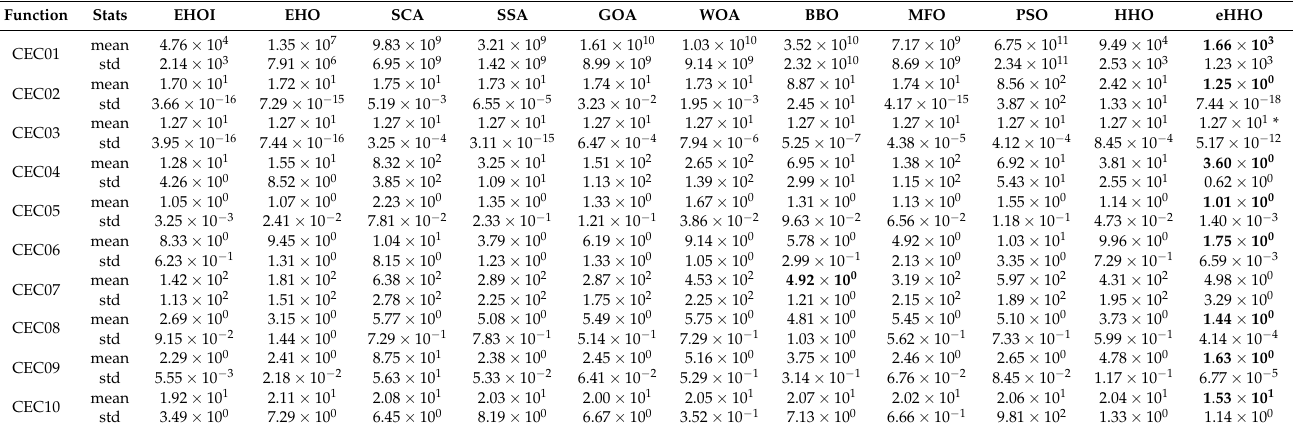
Table 3. Evaluation of results achieved by different well-known metaheuristics on CEC2019 benchmark function